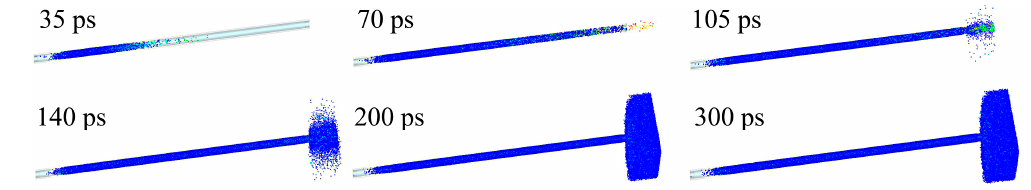
Figure 4. The trajectory of electron motion in the channel under the DC mode.